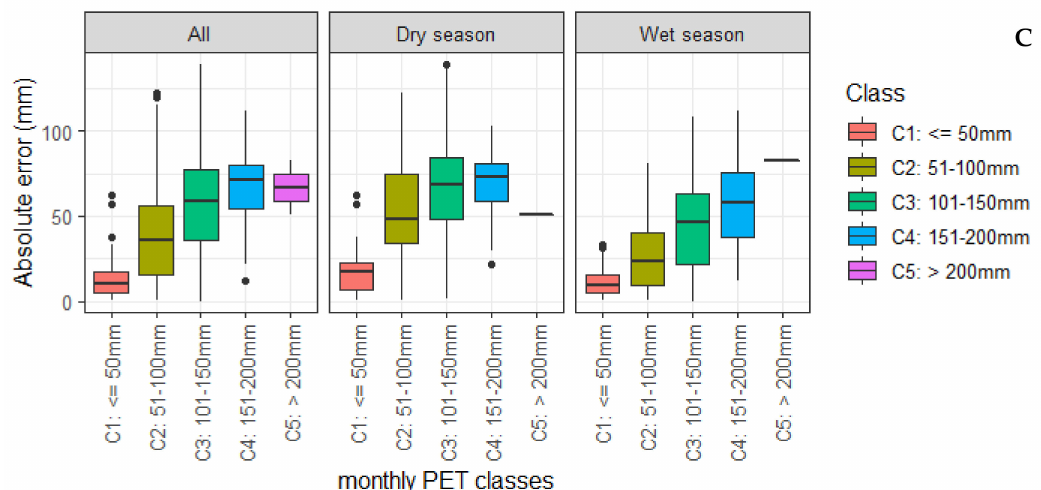
Figure 3. Probability distribution of monthly PET from native MODIS-16 PET (MOD) and field measurement (MET). ( A ) Validation plots of monthly PET from dry season and wet seasons, and combined ( B ), and absolute error patterns by measured PET classes ( C ).